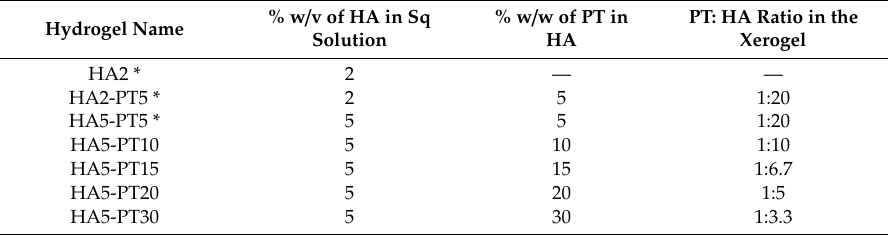
Table 2. Hydrogels formulated with HA and PT in alkaline pH conditions (pH =